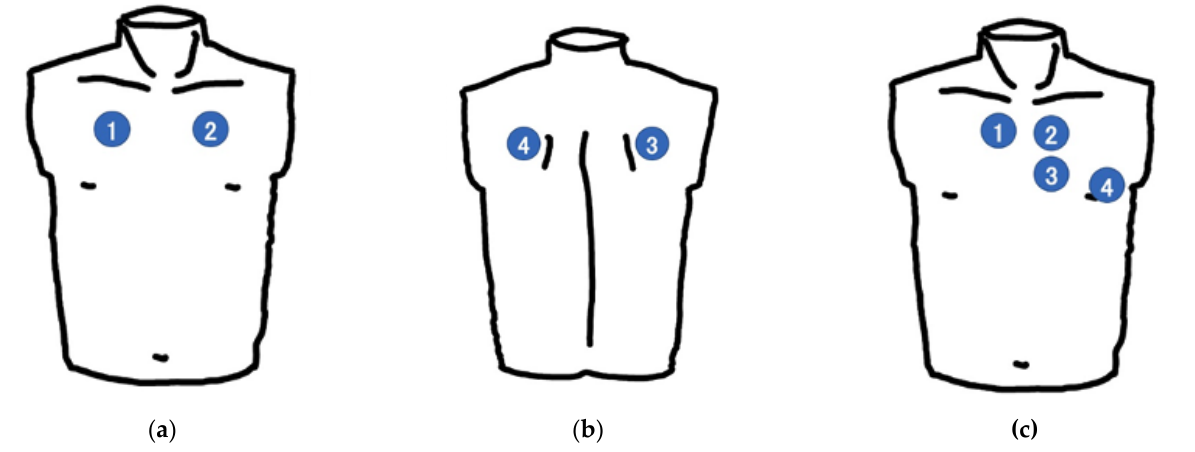
Figure 1. The four different areas of auscultation: ( a ) the anterior of the lung simulator, ( b ) the posterior of the lung simulator, ( c ) the cardiology patient simulator.